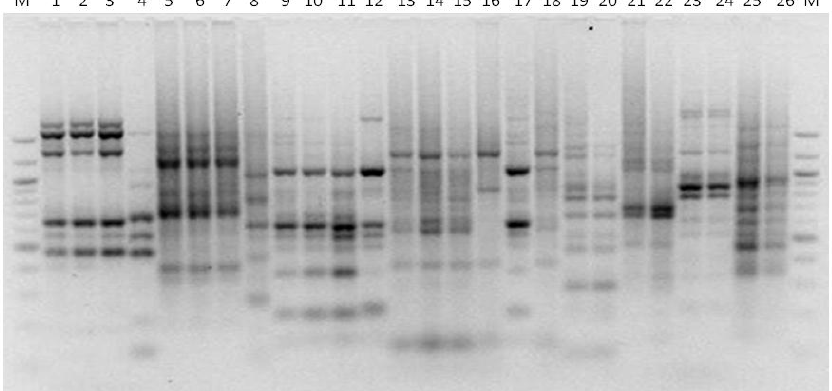
Figure 4. TRtRNA-PCR banding profiles generated with the primer pair ISSR-MB/TtRNASc (lanes 1–4, 9–12, 17, 19–20, and 23–24) and 5CAG/TtRNASc (lanes 5–8, 13–16, 18, 21–22, and 25–26). M: 100